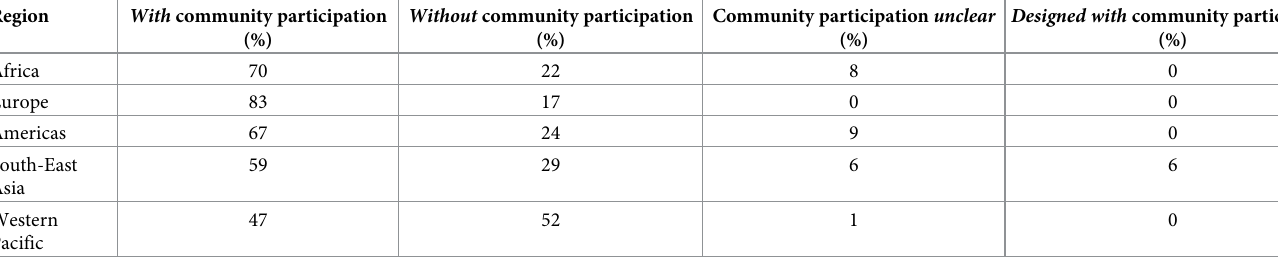
Table 4. Proportion of research studies with participation from host communities. Region With community participation